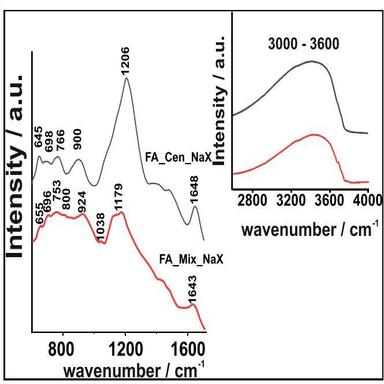
DRIFT spectra of FA_Mix_NaX and FA_Cen_NaX samples. In the insert close - up of the range of hydroxyl groups.